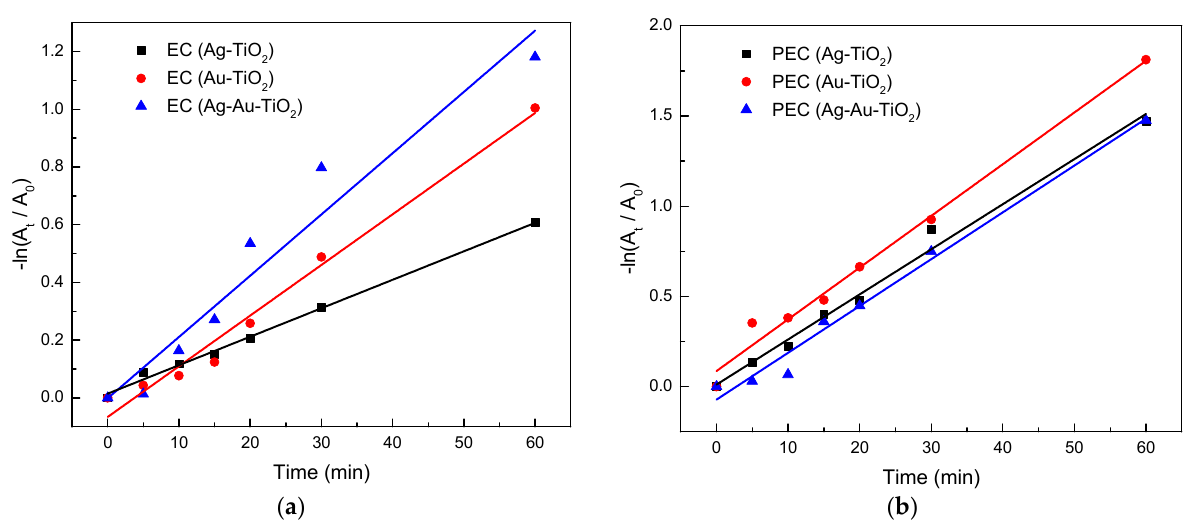
Figure 12. Pseudo-first-order kinetic fit of ( a ) EC and ( b ) PEC discoloration test of 50 ppm MG at 60 min. The degree of electrochemical enhancement (E) and the degree of process synergy (S) Table 1. Rate constant (K Obs ) values for the different photoanodes applied to EC and PEC processes. were calculated using Equations (1) and (2), as reported by Sample